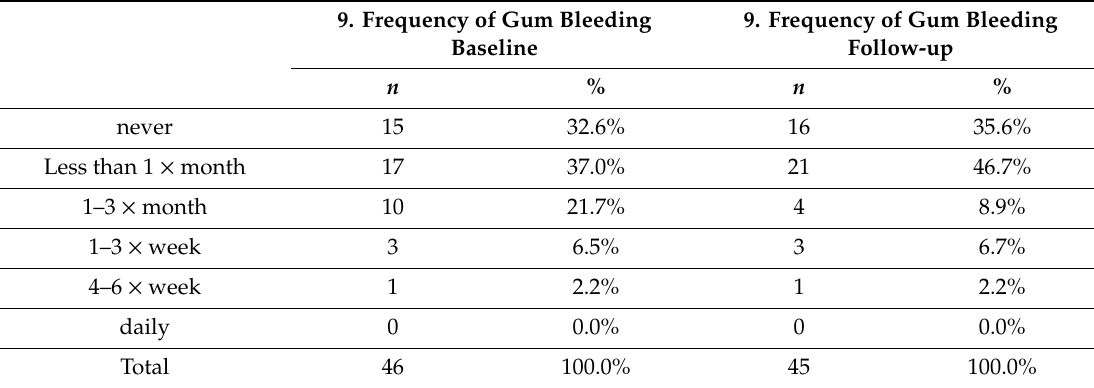
Table 7. Frequency of gum bleeding at baseline and at follow-up (after 4-week use of HAP